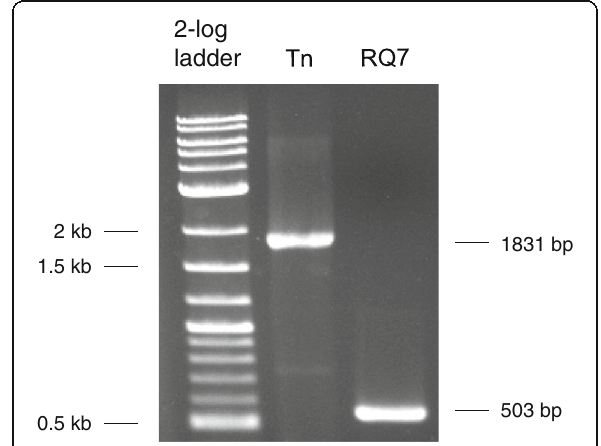
in T. sp. strain RQ7. T. neapolitana DSM 4359 (Tn) was used as the positive control. The expected sizes are 1831 bp in T. neapolitana DSM 4359 and 503 bp